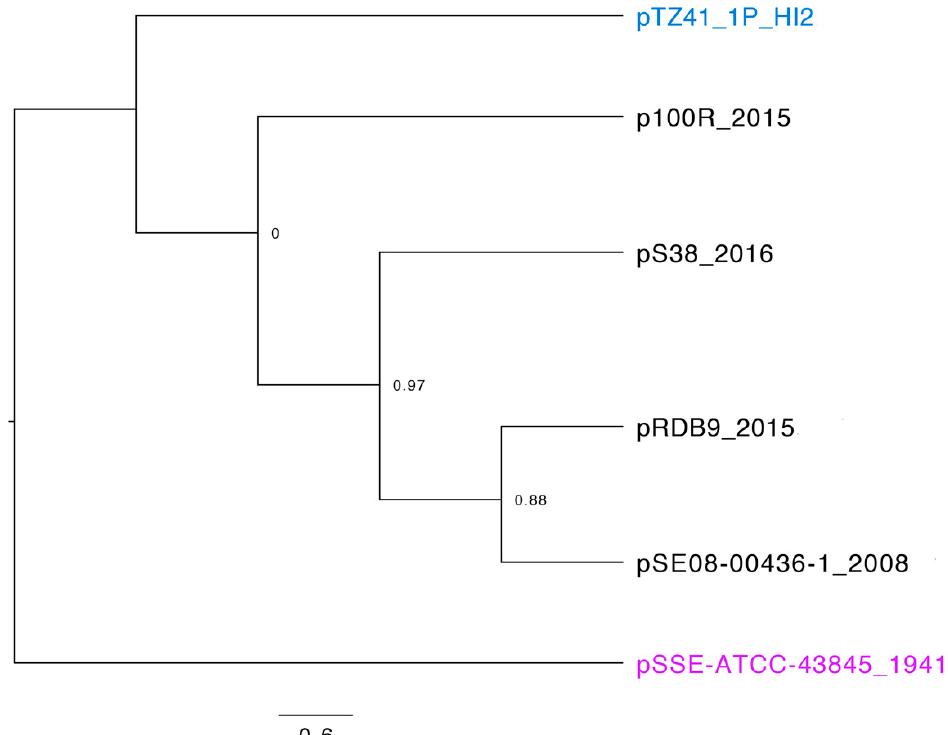
Figure 4. A maximum-likelihood phylogenetic tree of closely related IncHI2-ST4 plasmid sequences downloaded from GenBank. The tree was rooted using a sequence of the oldest known plasmid pSSE-ATCC-43845 belonging to the IncHI2-ST4 lineage in 1941. Node values represent confidence scores. The scale represents substitutions per site.